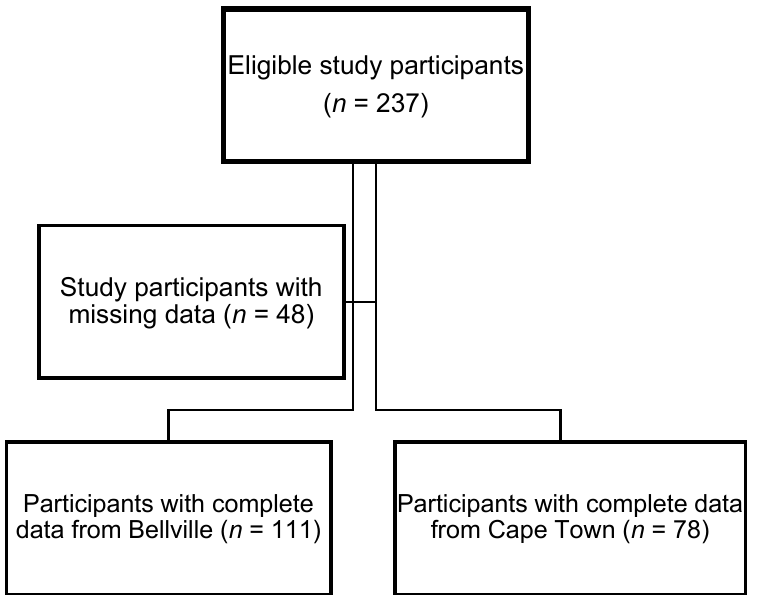
Figure 1. Flow diagram of participants included in the analytical sample.